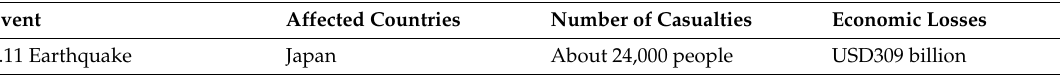
Table 1. Major Natural